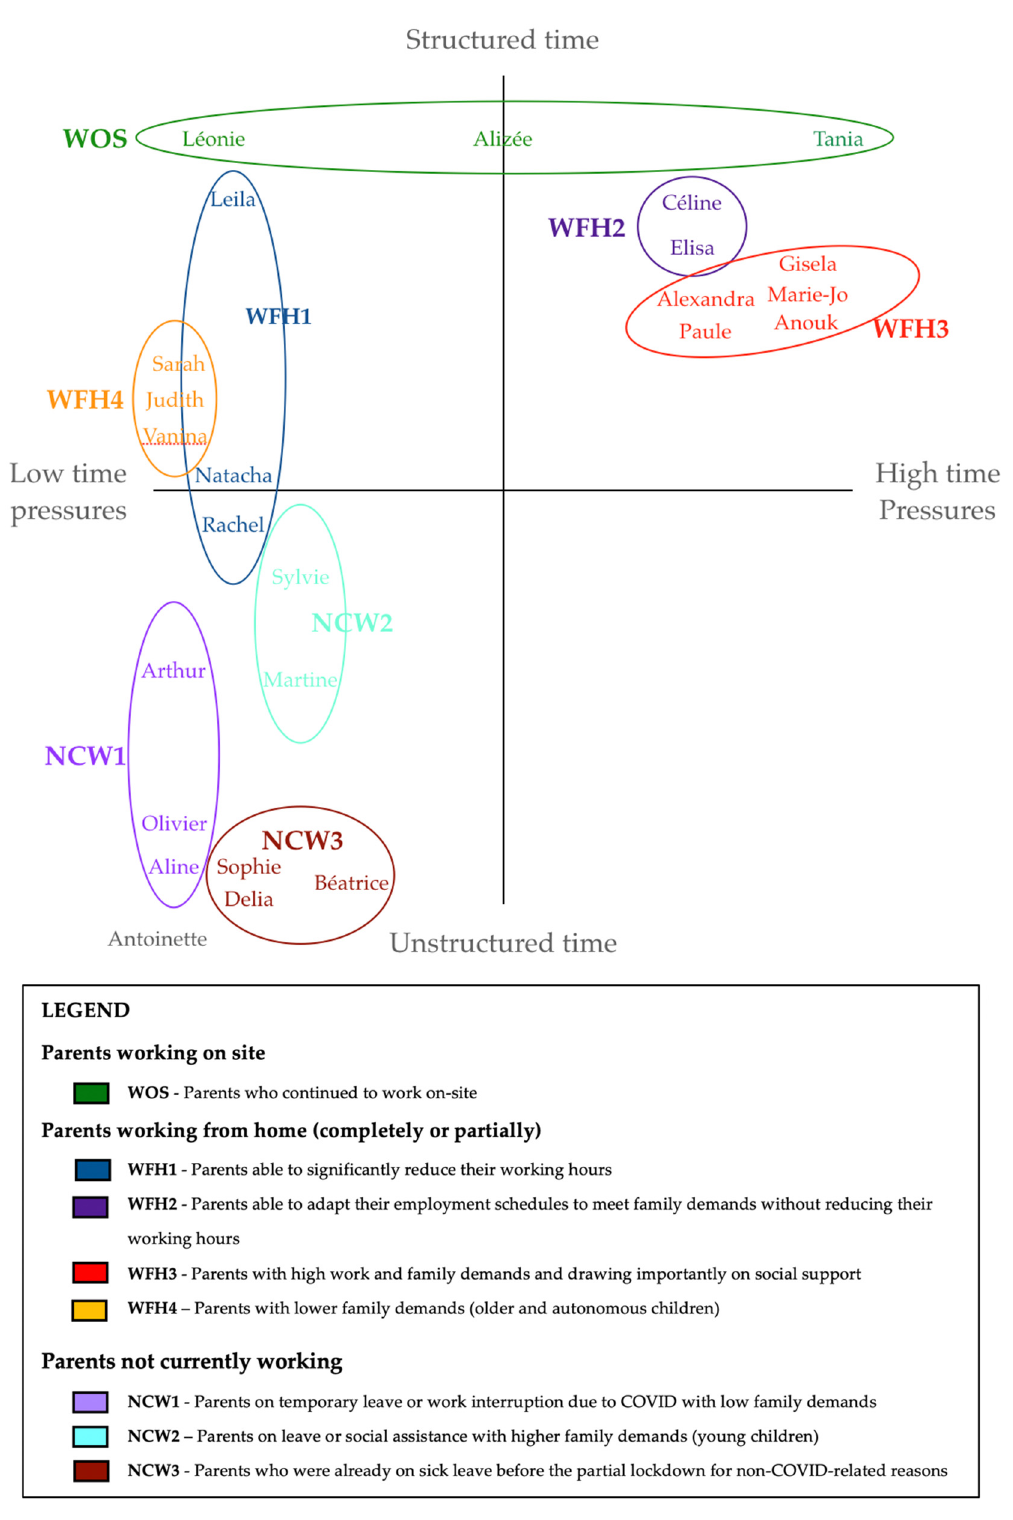
Figure 1. Mapping of cases and groups according to the level of temporal pressures and degree of temporal structuring. Viviane’s case is not classified due to the specificity of her situation, which changed significantly during the period and was affected by her health conditions.